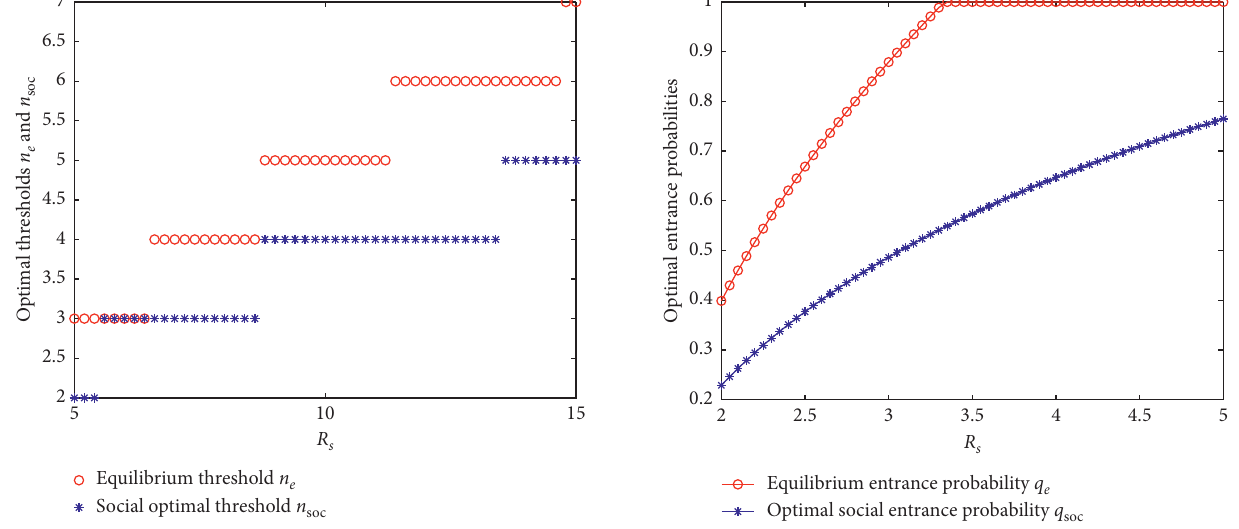
Figure 4: Equilibrium and social optimal joining probabilities s versus R s ( C � 3 , R f � 1 , λ � 1 . 5 ) .